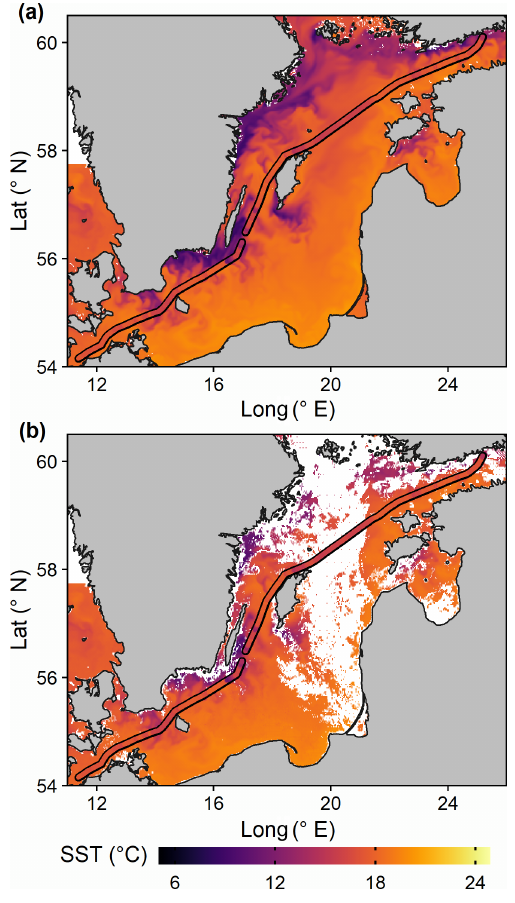
Figure 3. SST in the Baltic Sea on 16 August 2016 (daily mean) as extracted from (a) the model and (b) the remote sensing prod- uct (see text). SST measurements aboard SOOP Finnmaid from the same day are plotted on top of both panels. We chose this day for demonstration purposes as a best compromise between remote sens- ing and SOOP data coverage as well as observable upwelling sig- nals. Animation S1 contains an animation over time with the same colour